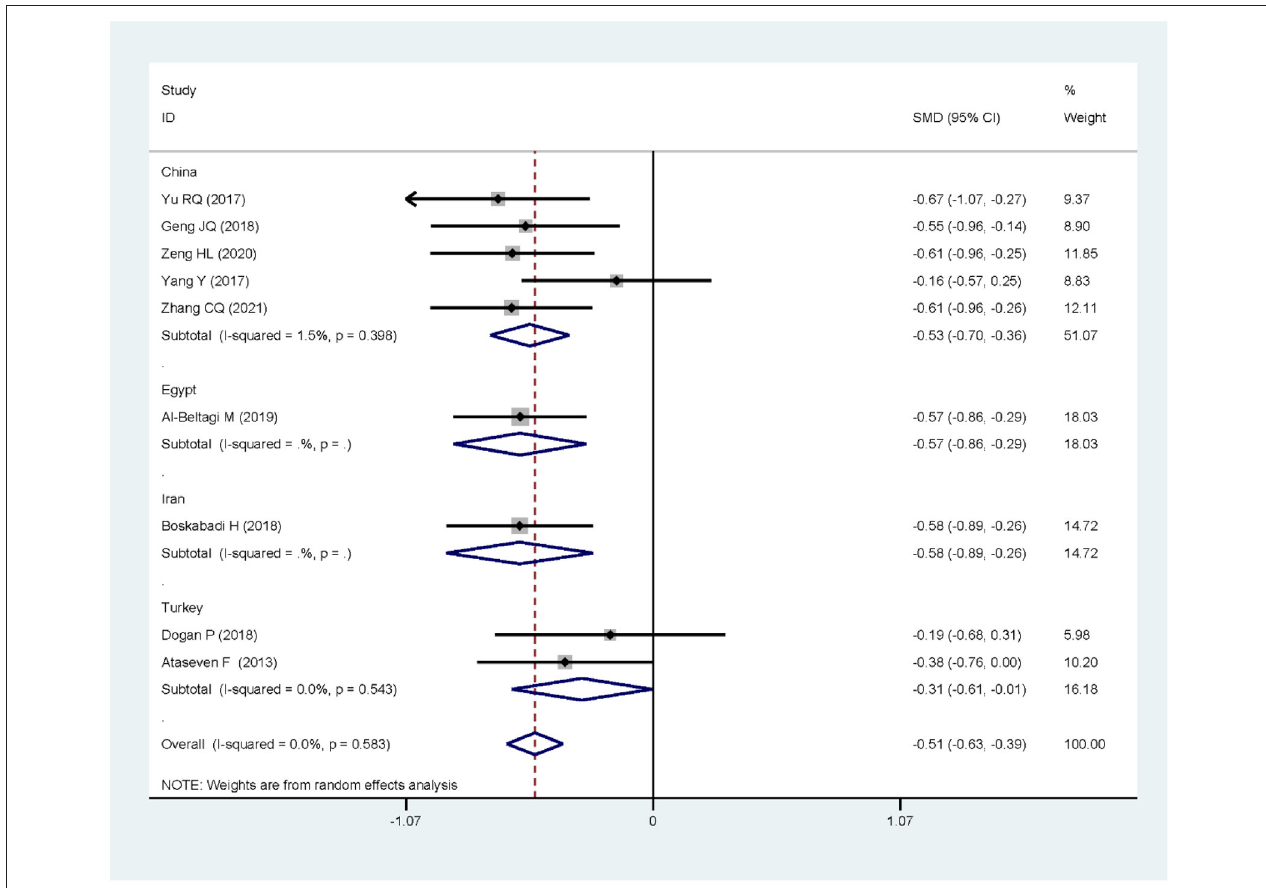
FIGURE 4 | Result of subgroup analysis categorized in countries.